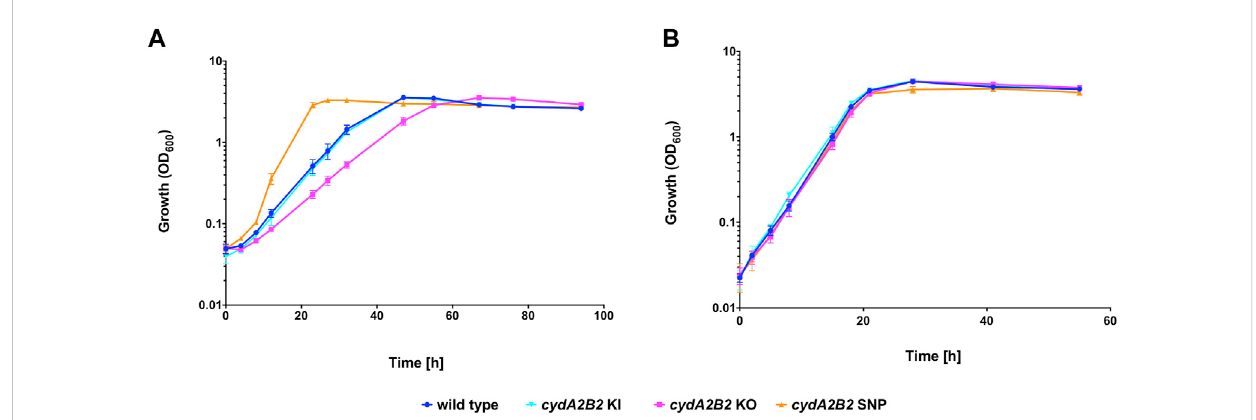
FIGURE 6 Heterotrophic growth in the presence of CO of cydA2B2 KO, cydA2B2 SNP, and cydA2B2 KI strains compared to the H16 wild type. Cultures were grown at 30 ° C in 20 mL F-MM contained in 150 mL serum bottles under a 2 bar atm of (A) 50% CO/50% air (v/v) or (B) 50% N 2 /50% air (v/v). Blue circles, wild type; orange triangles, cydA2B2 SNP; pink squares, cydA2B2 KO; cyan inverted triangles, cydA2B2 KI. Error bars represent the standard deviation of the mean for three independent